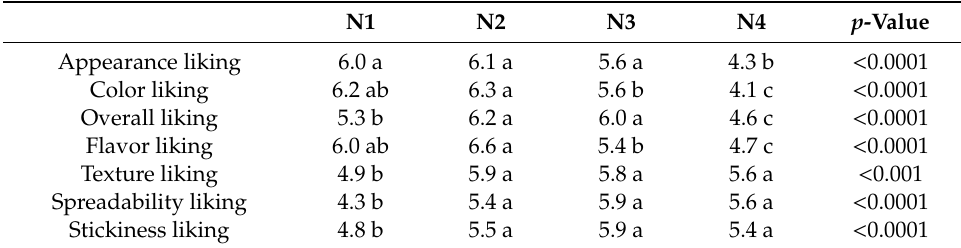
Table 5. Consumer acceptance test results for Nuroongji